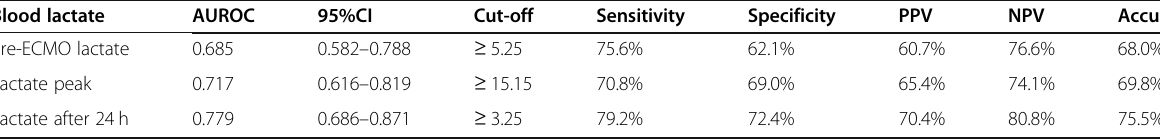
Table 4 The validity measures of blood lactate in differentiating cerebral damage Blood lactate AUROC 95%CI Cut-off